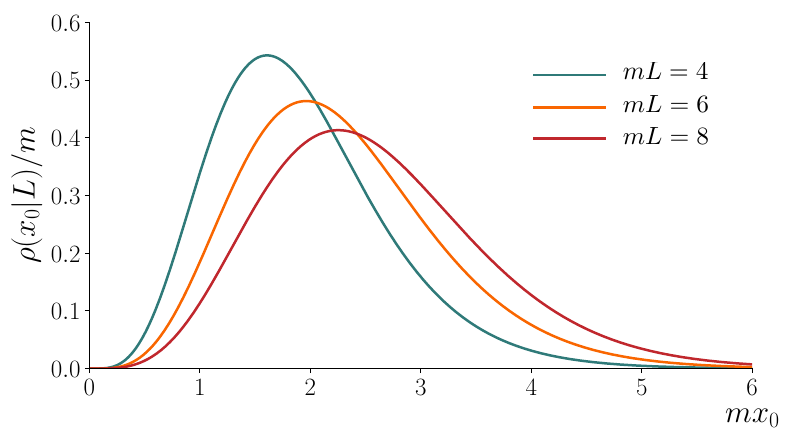
Figure 2 . Plot of (cid:26) ( x 0 j L ) =m vs. mx 0 for three values of mL . The quantity (cid:26) ( x 0 j L ) dx 0 gives the relative contribution of the interval [ x 0 ; x 0 + dx 0 ] to the integral in eq. (2.9) de(cid:12)ning the (cid:12)nite- L corrections. Note that the area under each curve is equal to 1, by construction.